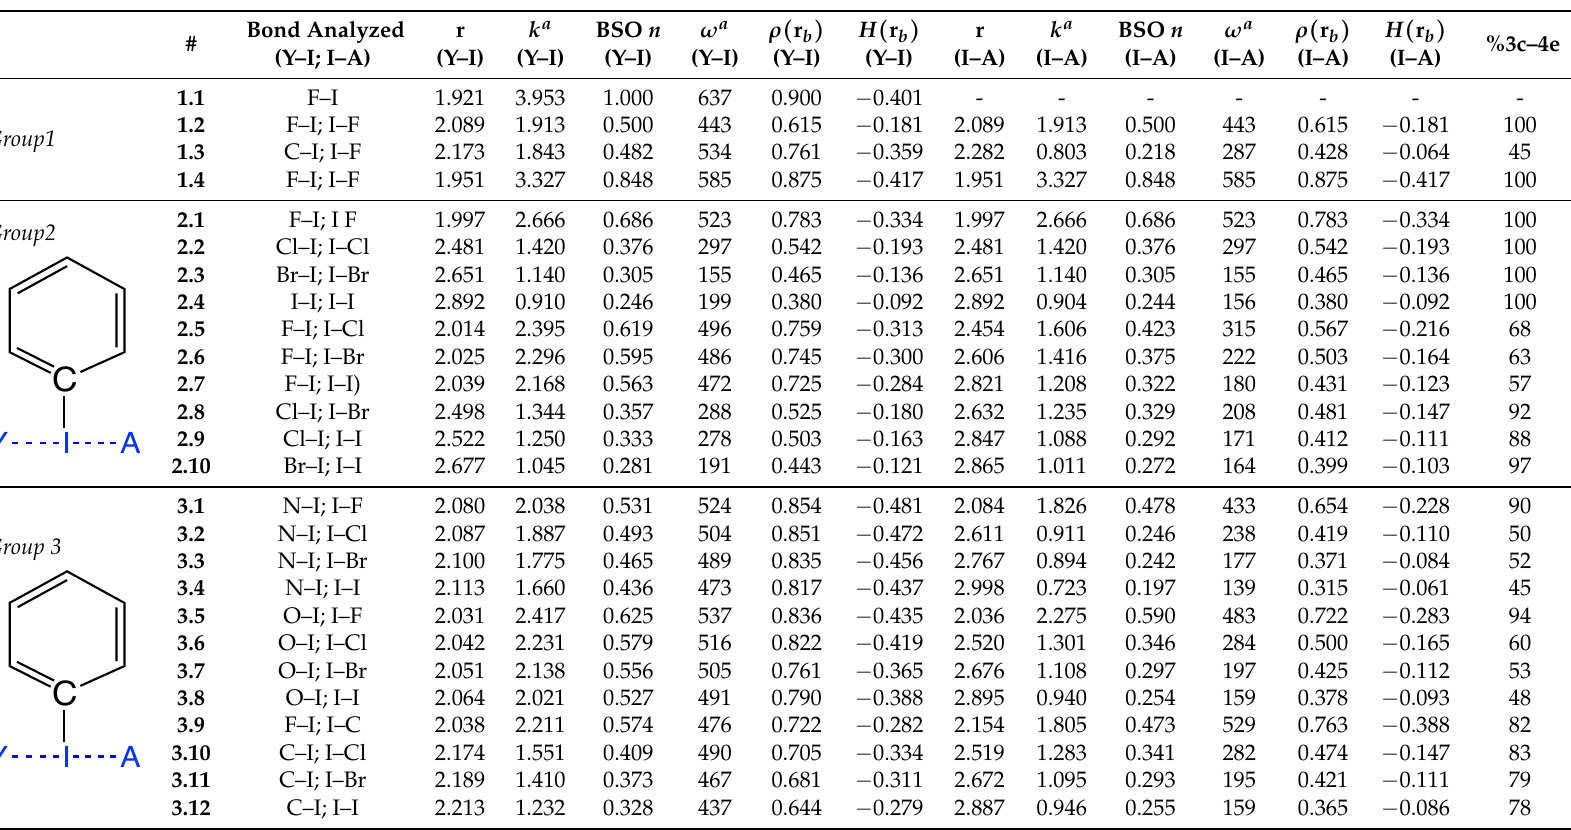
Table 1. Bond distance (r), k a , ω a , BSO n , ρ ( r b ) , H ( r b ) , and %3c–4e for Y–I ( 1.1 ), Y–I · · · A ( 1.3 ), and Y · · · I · · · A bonds in 1.2, 1.4–4.8 , where Y = A in 2.1–2.4 , Y–I = the stronger of the two axial bonds in 1.3 and 2.5–4.8